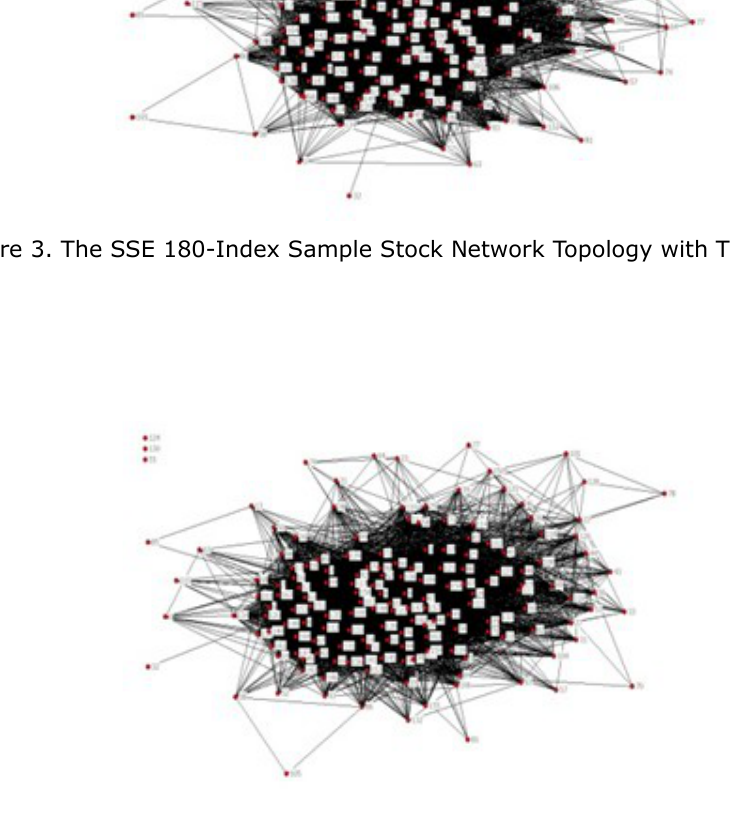
Figure 4. The SSE 180-Index Sample Stock Network Topology with Threshold